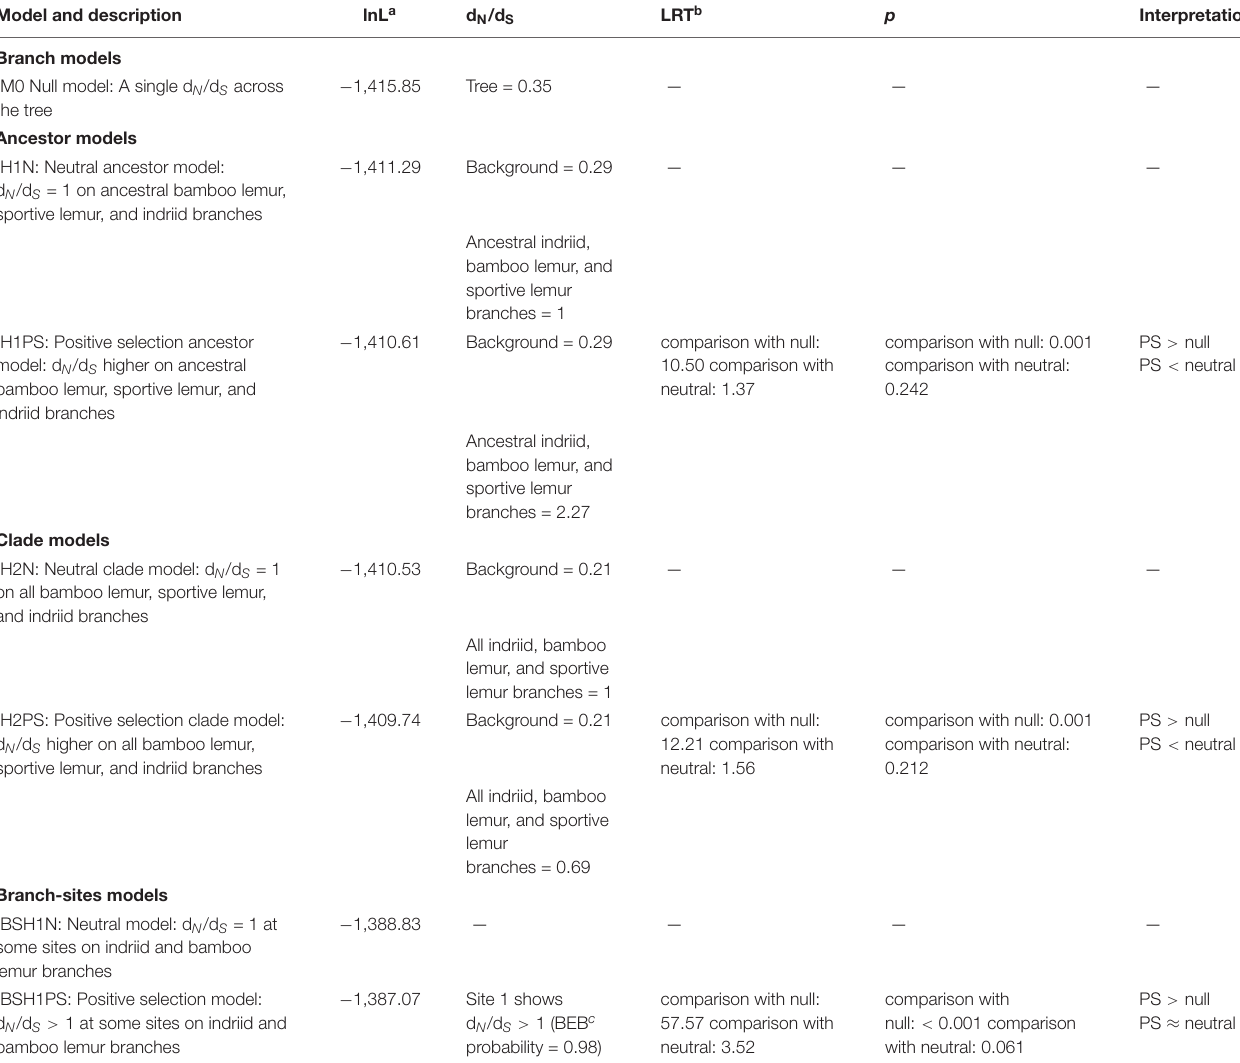
TABLE 2 | Results of codeml analysis.